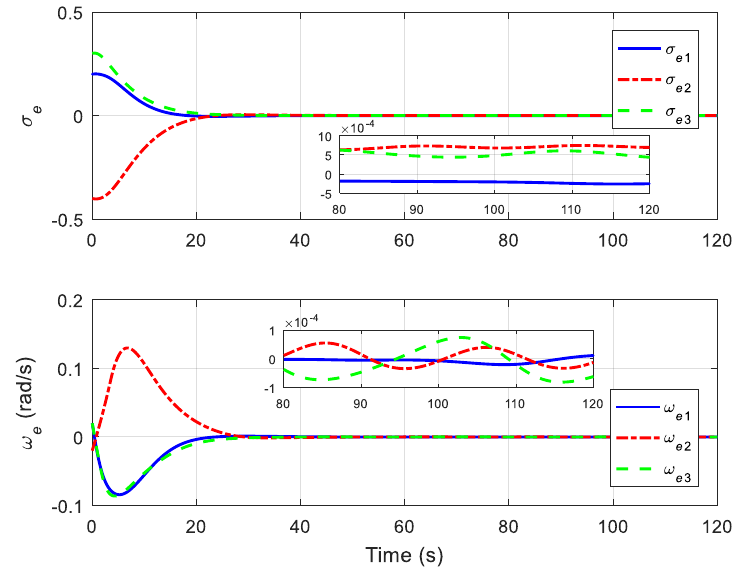
Figure 4. Relative attitude and angular velocity under the proposed controller.